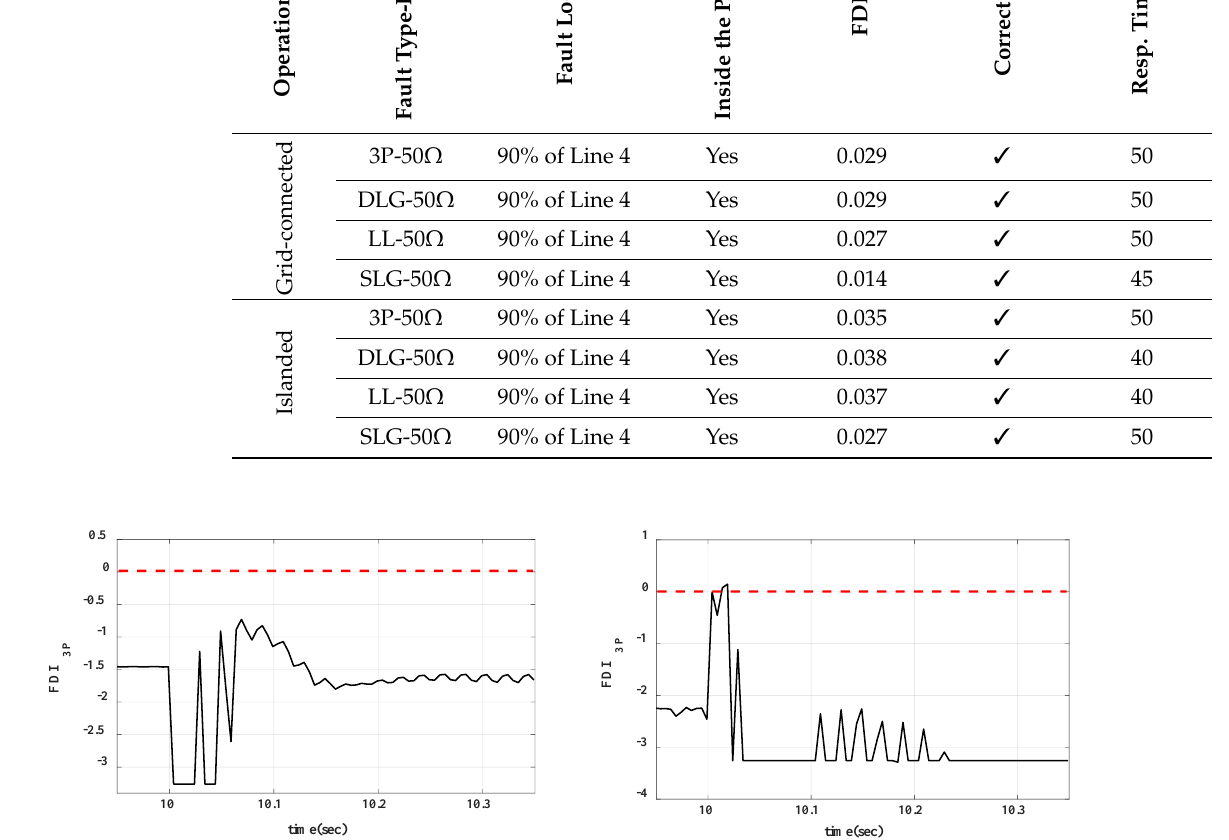
Table 5. Performance of the proposed main scheme in new pre-fault conditions.